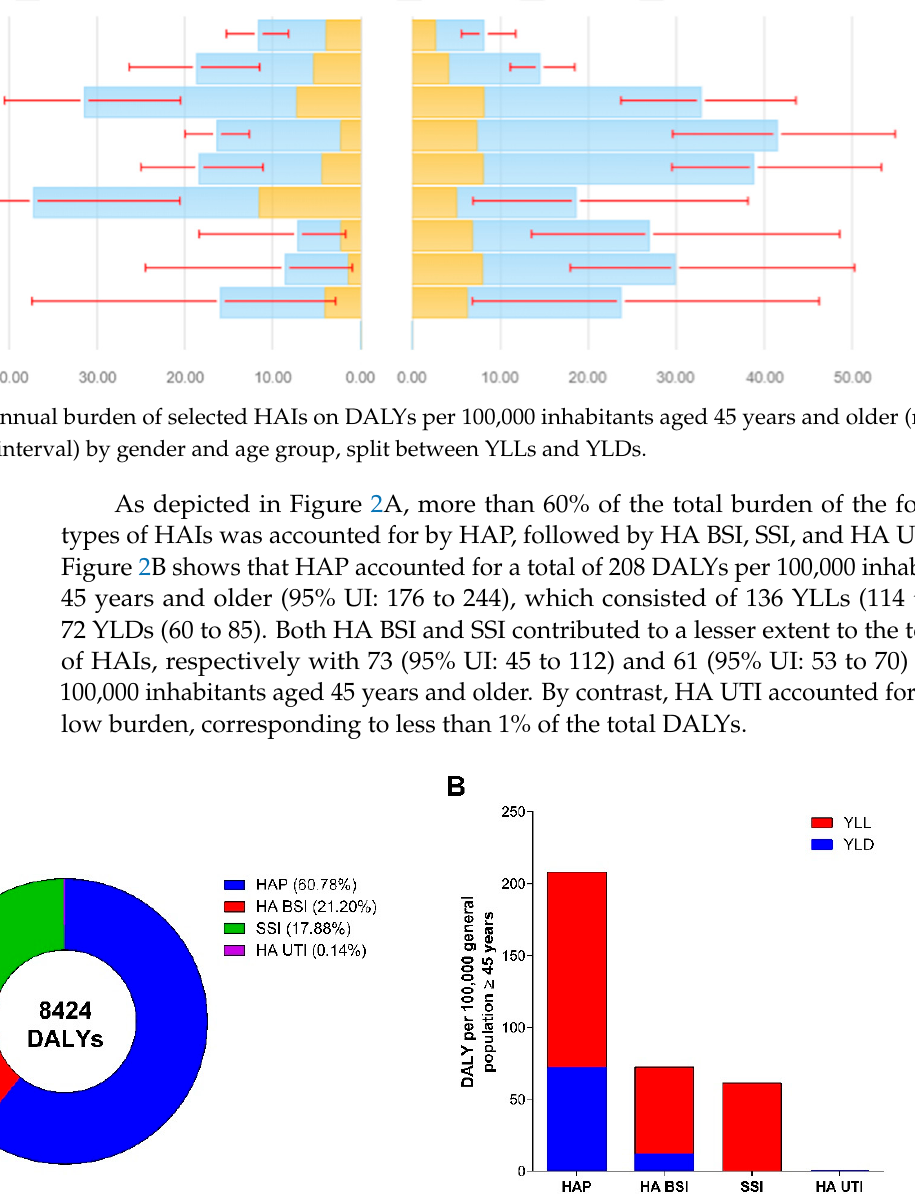
Figure 2. Estimated annual burden in DALYs by different types of HAI: ( A ) The proportion of the total burden on DALYs for each of the selected HAI types; ( B ) Estimated annual burden in DALYs per 100,000 inhabitants aged 45 years and older by different HAI types, split between YLLs and YLDs.